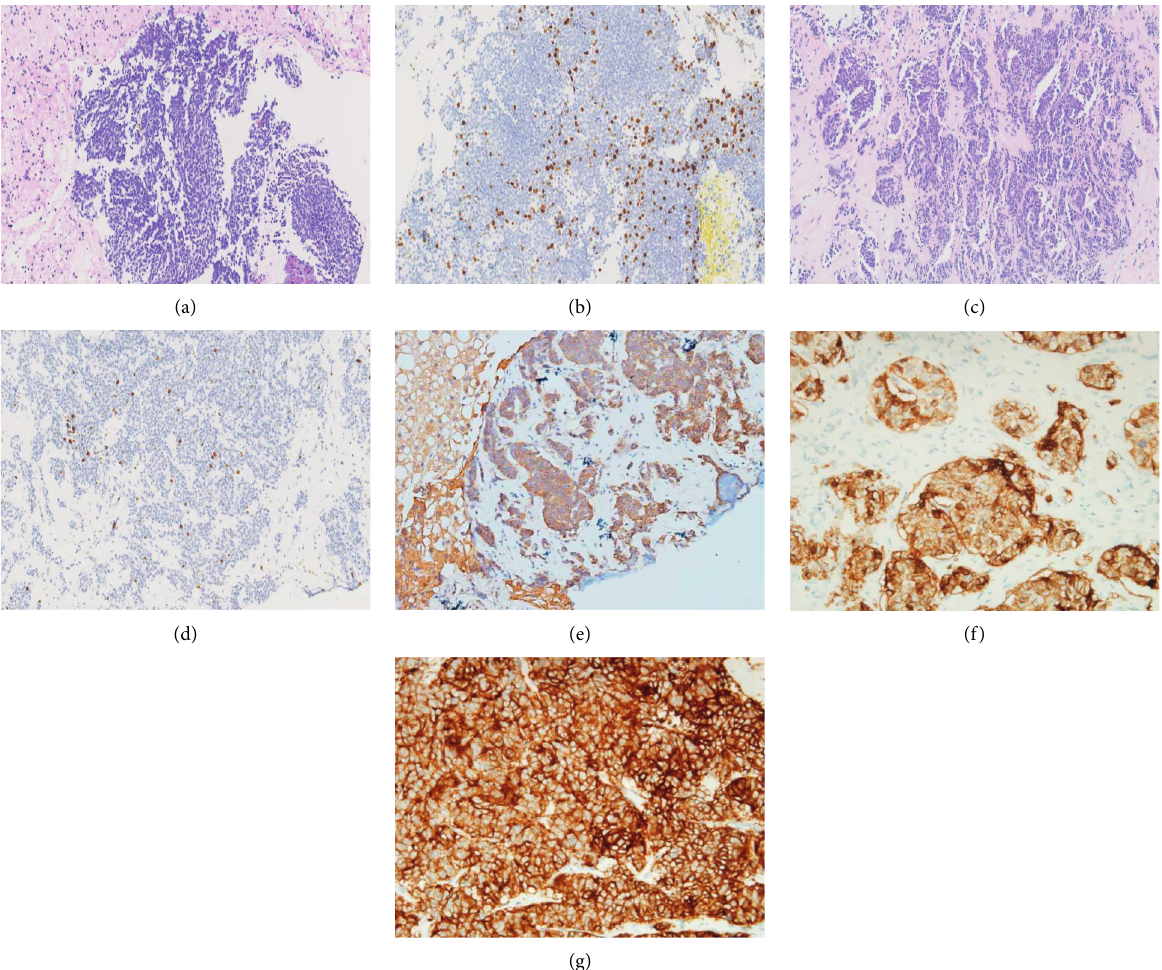
Figure 2: Pathology and immunochemistry staining of tumors of the pancreas (a, b, e, and f) and liver metastasis (c, d, and g). (a) Pancreatic neuroendocrine tumor (hematoxylin and eosin staining, magnification × 200); (b) the percentage of Ki-67-positive cells (brown color) was 15% in the pancreatic tumor (magnification × 200); (c) liver metastases of the neuroendocrine tumor (hematoxylin and eosin staining, magnification × 200); (d) the percentage of Ki-67-positive cells (brown color) was 10% in the hepatic metastases (magnification × 200); (e) positive immunostaining for CRH (brown color) in the liver metastasis (magnification × 200); (f) & (g) positive immunostaining for SSTR2 (brown color) in the pancreatic tumor (magnification × 400) (f) and in the hepatic metastases (magnification × 400)